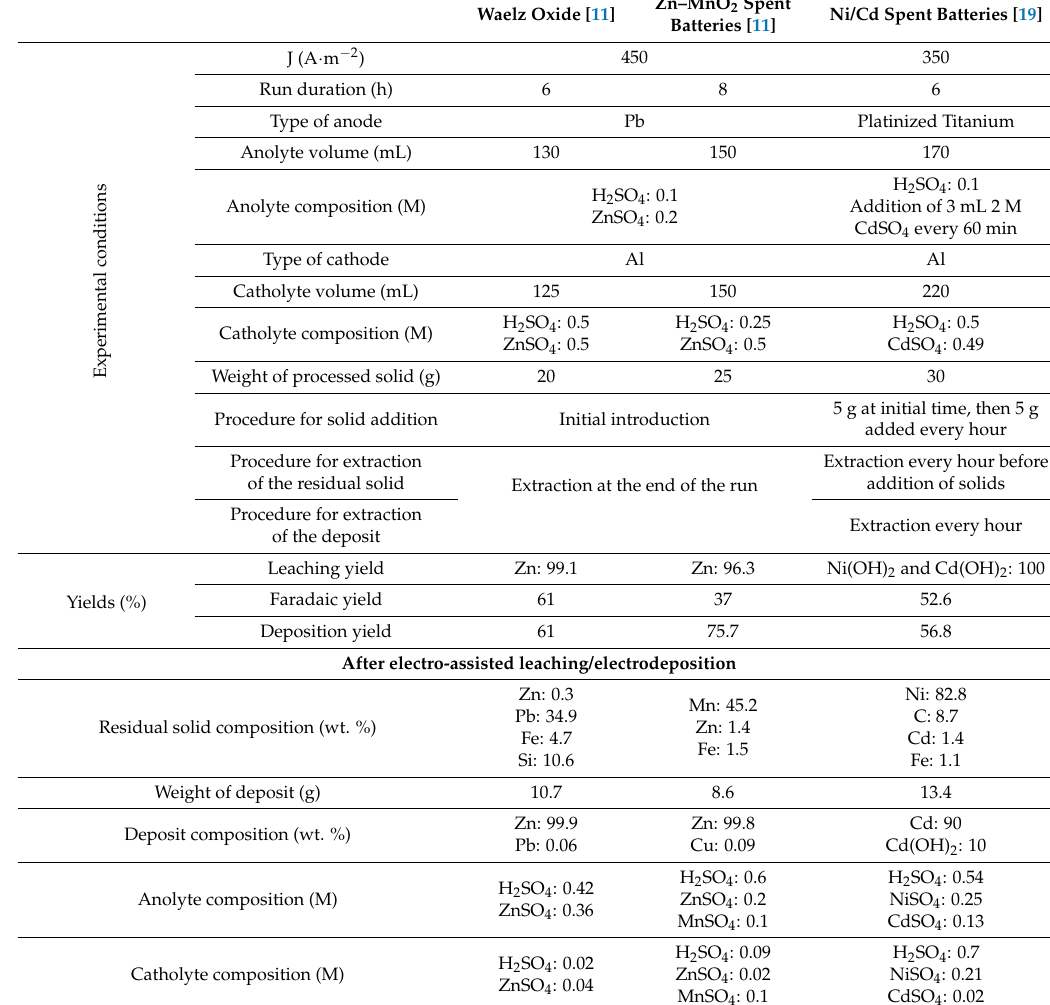
Table 4. Electro-assisted leaching/electrodeposition of various industrials wastes (or byproduct) in the discontinuous